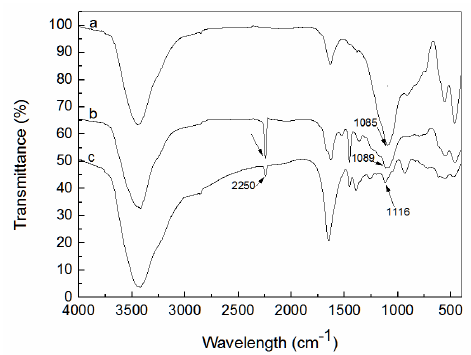
Figure 1. FT-IR spectra of FA pretreated with HCl (a), polyacrylonitrile/fly ash composite (b), and amidoxime-modified polyacrylonitrile/fly ash composite (c).